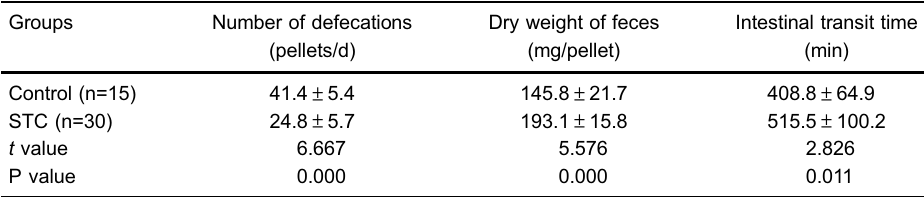
Table 1. Comparison of defecation condition in control and slow transit constipation (STC) rats after 100 days of diphenoxylate treatment. Groups